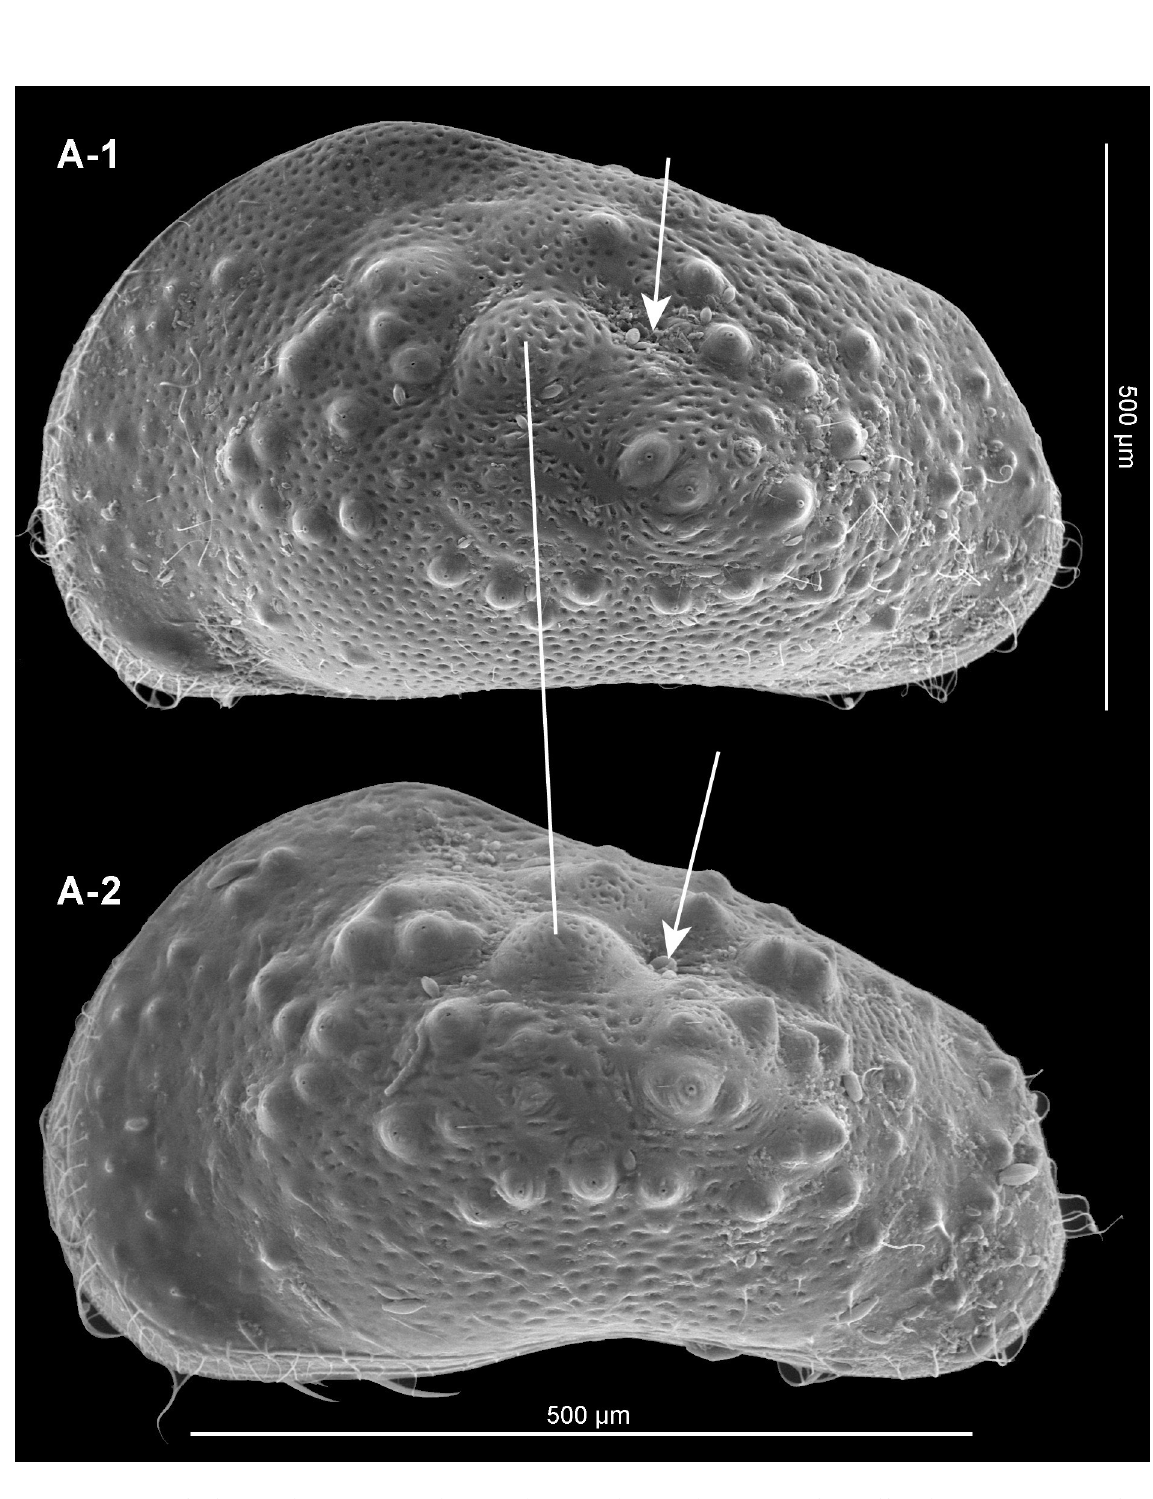
Fig. 7. External views of carapaces of Bennelongia cf. nimala nov. sp. juveniles from Muggon Lake, showing left valves in order to compare the ornamentation between an A-1 specimen (top) and A-2 specimen (bottom). The arrows indicate a clear depression postero-dorsally to each dome, that are linked by a white